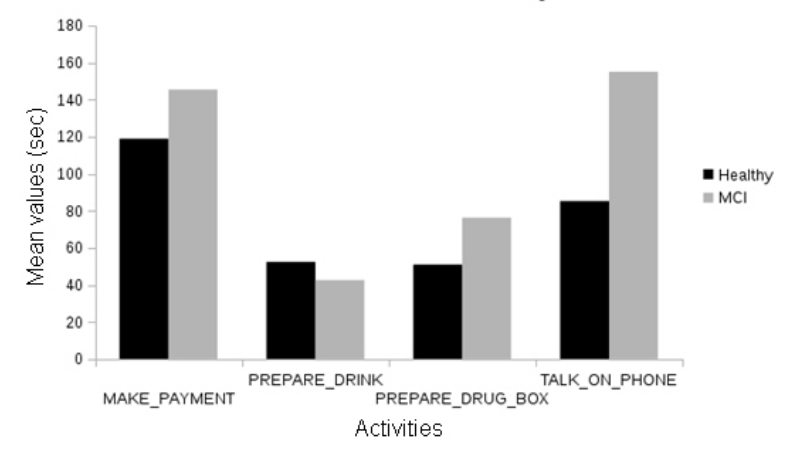
Figure 9. Comparison between the duration of automatically recognized events of the different cognitive status groups of the Nice pilot.